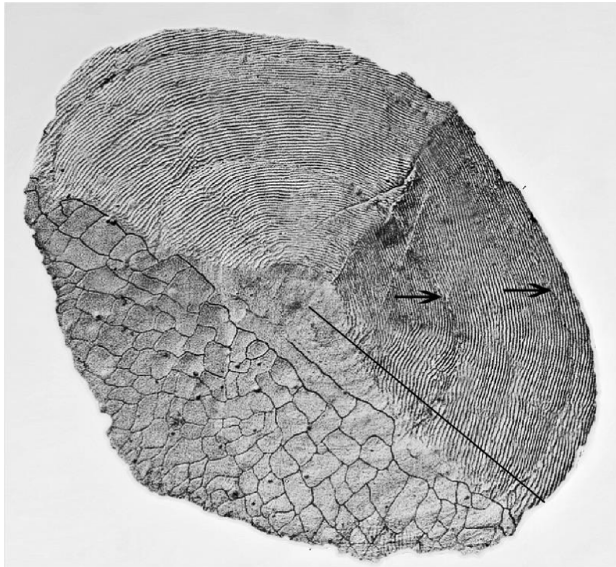
Fig. 2. A scale of Coilia brachygnathus specimen aged 3 (20.9 cm SL). Black line is the axis for measuring the radius and arrows highlight the